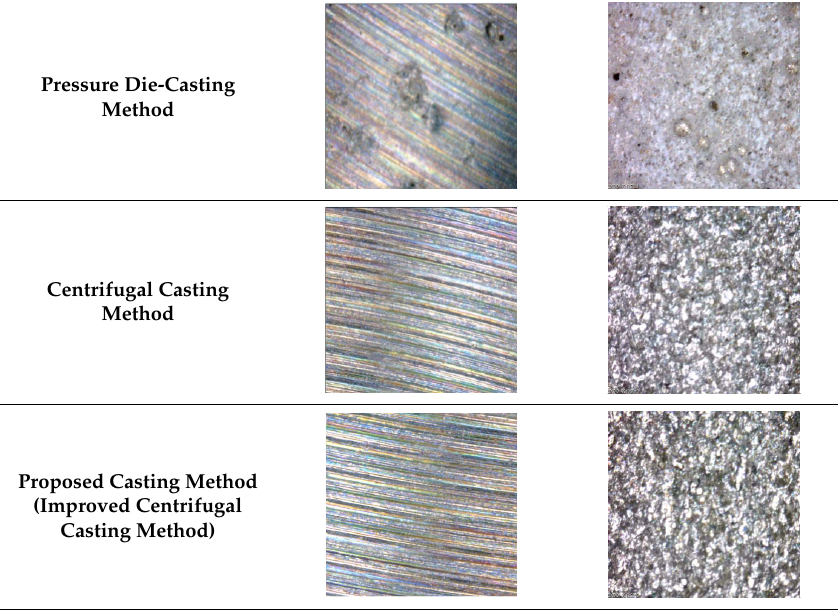
Table 3. The cutting plane and the texture state of the rotors.